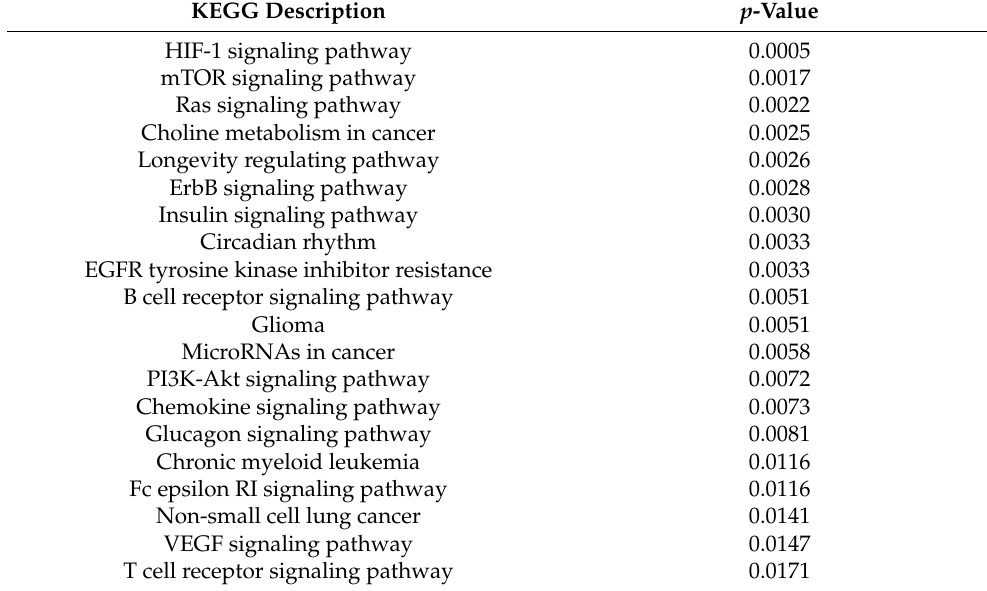
Table 3. KEGG enriched pathways associated with the replication of